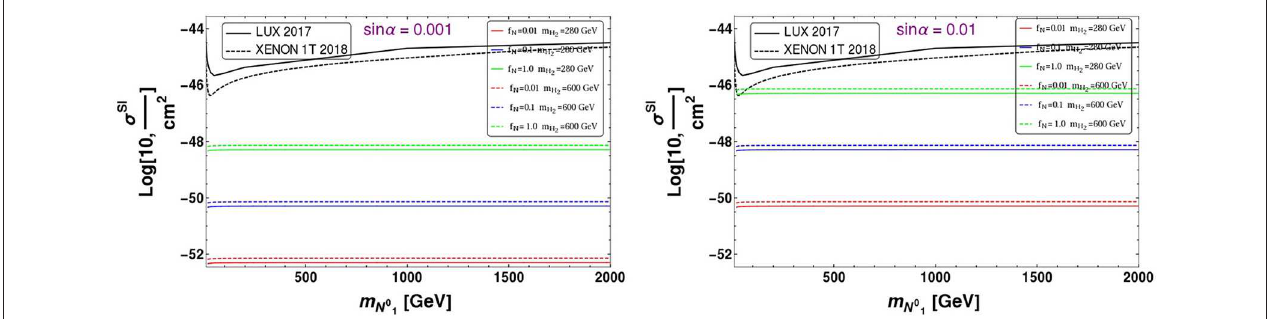
0.01 (Right) . Different choices of the coupling =